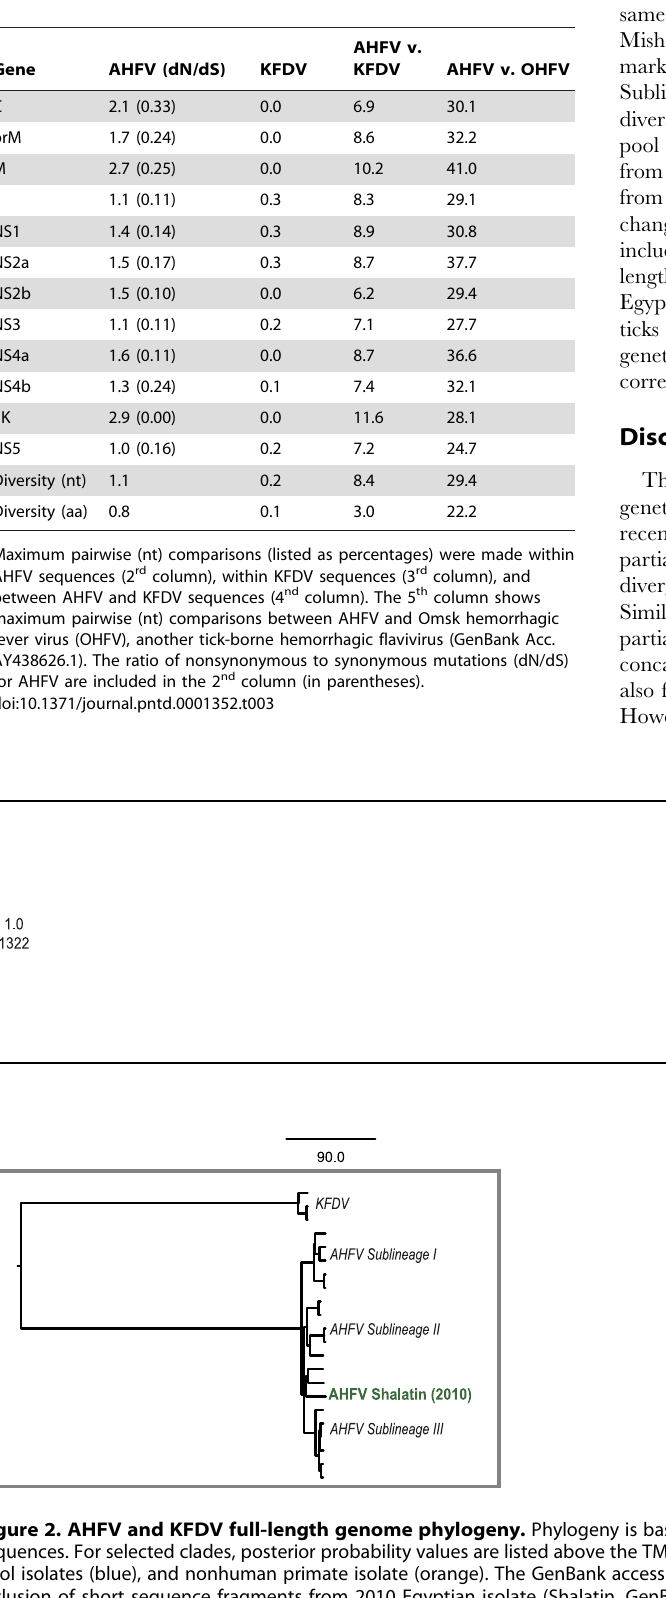
Table 3. Gene-specific genetic diversity.